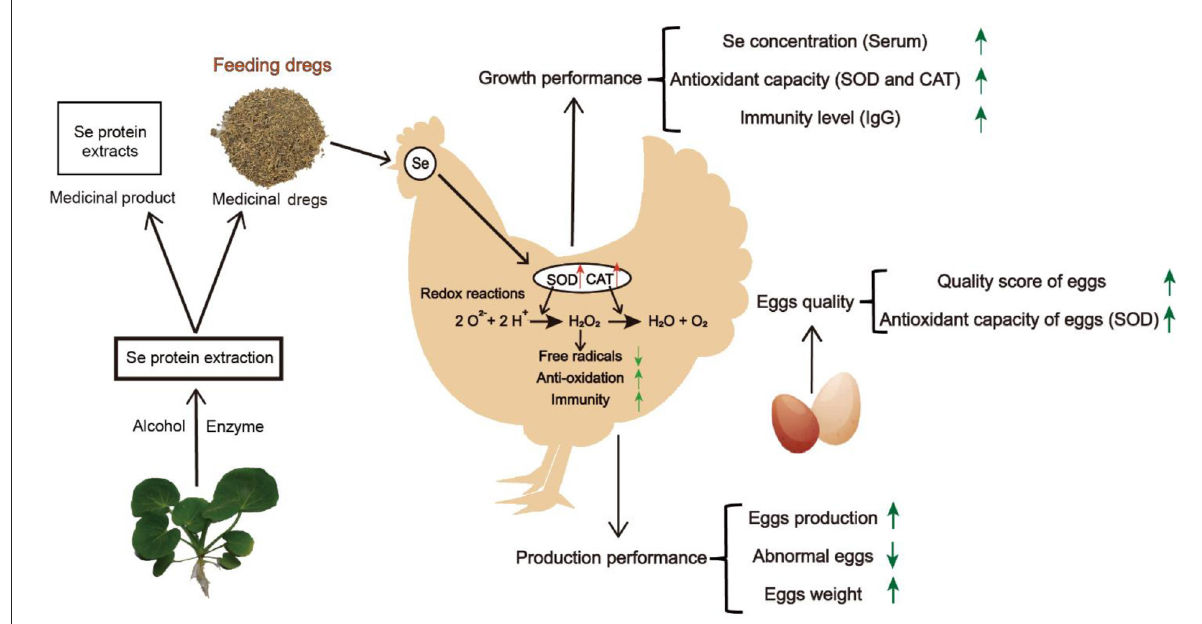
FIGURE3 The DCH was added into diet as an additive to feed laying hens, which increased the content of serum selenium, improved the levels of SOD and CAT, accelerated the elimination of free radicals, improved the antioxidant capacity and immunity, and then enhanced the production performance and egg quality of laying